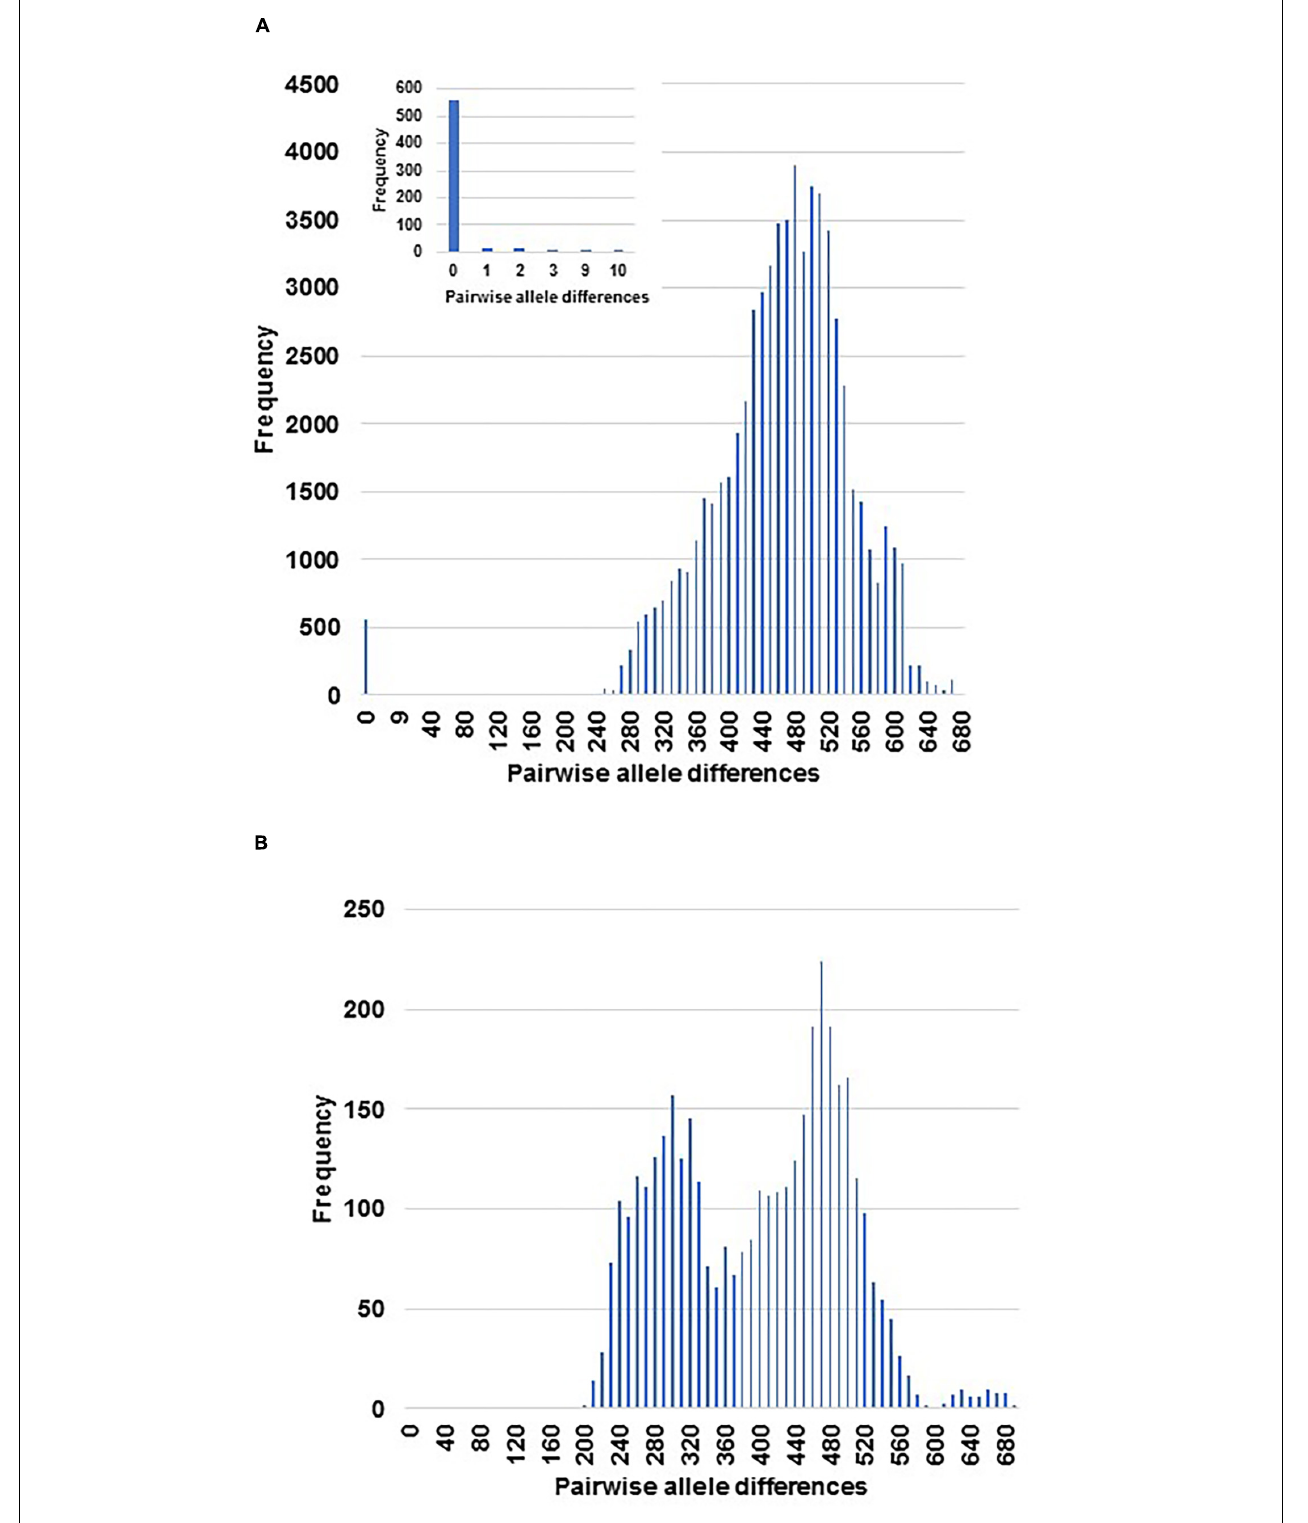
FIGURE 1 | Representation of the genetic distances among the entire cultivated sample set and the genotypes from the cross ‘Picual’ x ‘Arbequina’ cultivars (A) and the wild genotypes (B) . The distances were measured in number of different alleles for the pairwise comparisons among the set of samples under study with 1043 EST-SNPs. The small window is a zoom for the smallest distance zone among cultivated samples.